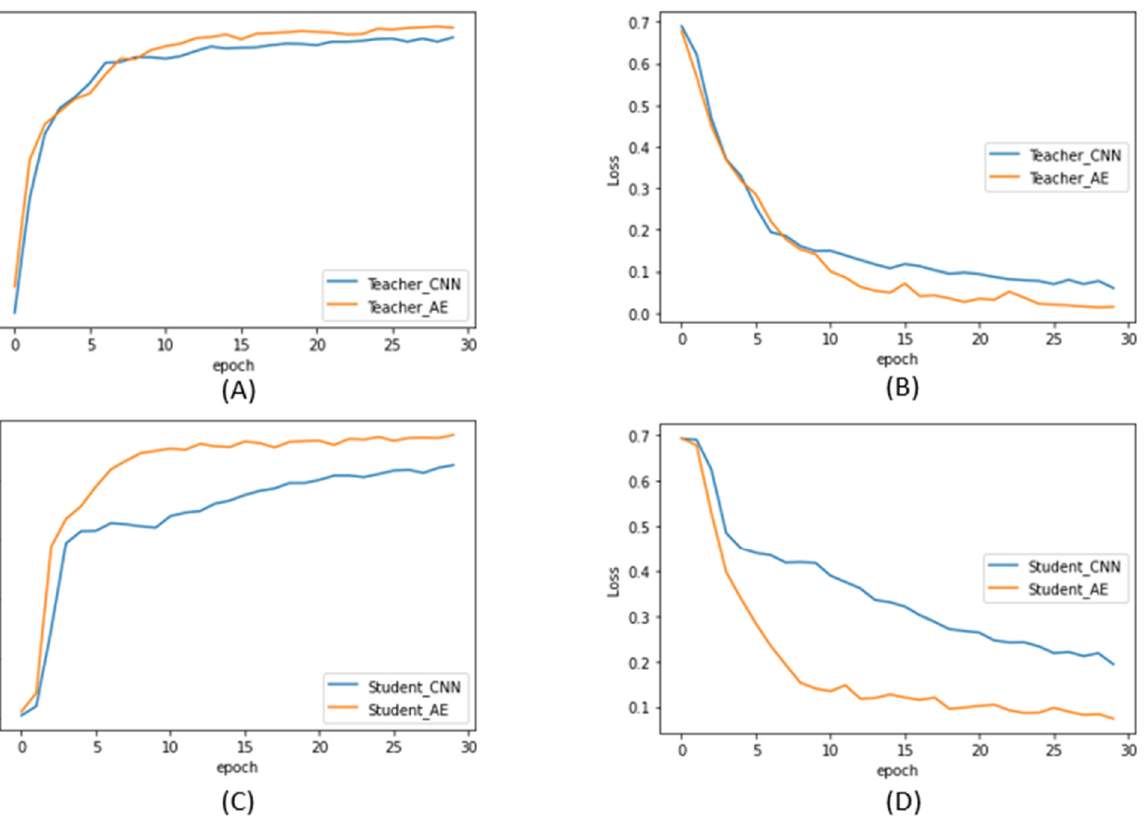
Table 5. Casting dataset experiment results.